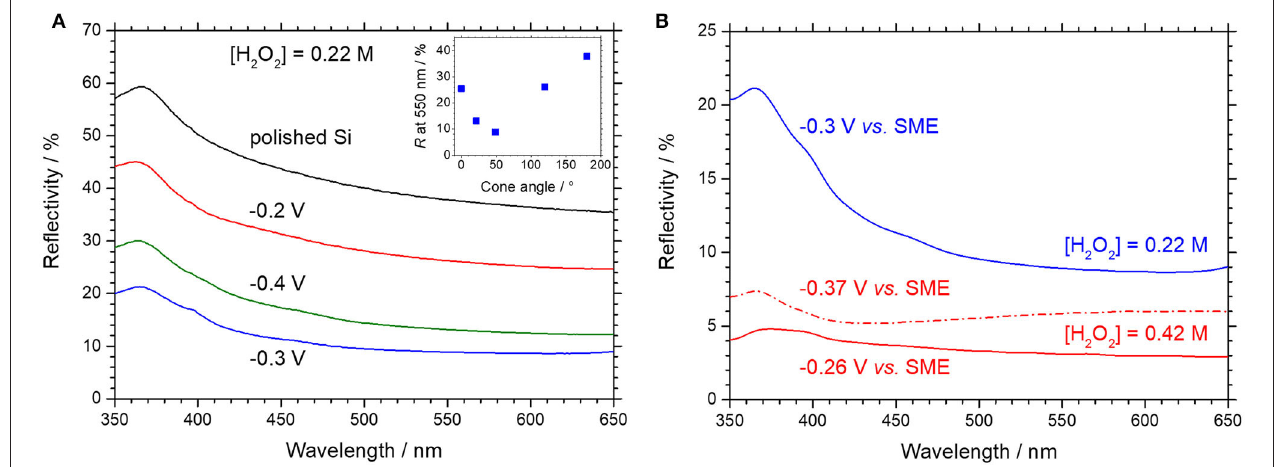
FIGURE 10 | Surface reflectivity of p-type silicon covered with cone shaped macropores obtained by MACE under anodic polarization, followed by dissolution of porous silicon in HF/HNO 3 . MACE is performed in 1.24mol L − 1 [HF] and (A) 0.22mol L − 1 [H 2 O 2 ] or (B) 0.42mol L − 1 [H 2 O 2 ]. Anodic potentials applied during MACE are indicated in all cases. The inset of (A) gives the reflectivity at 550nm as a function of the cone